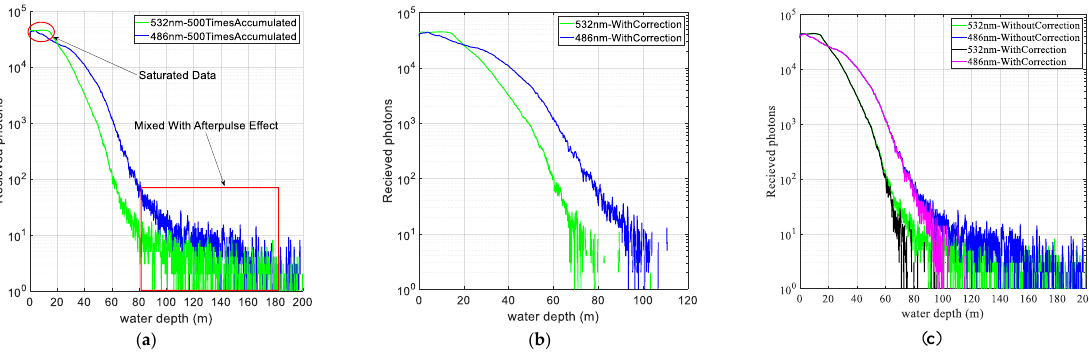
Figure 14. ( a ) Results of received photons for 500 accumulated frames without any corrections, ( b ) result of received photons, with the total dark count (TDC) and the after-pulse count (APC) removed; ( c ) comparison between the original results and the corrected results.